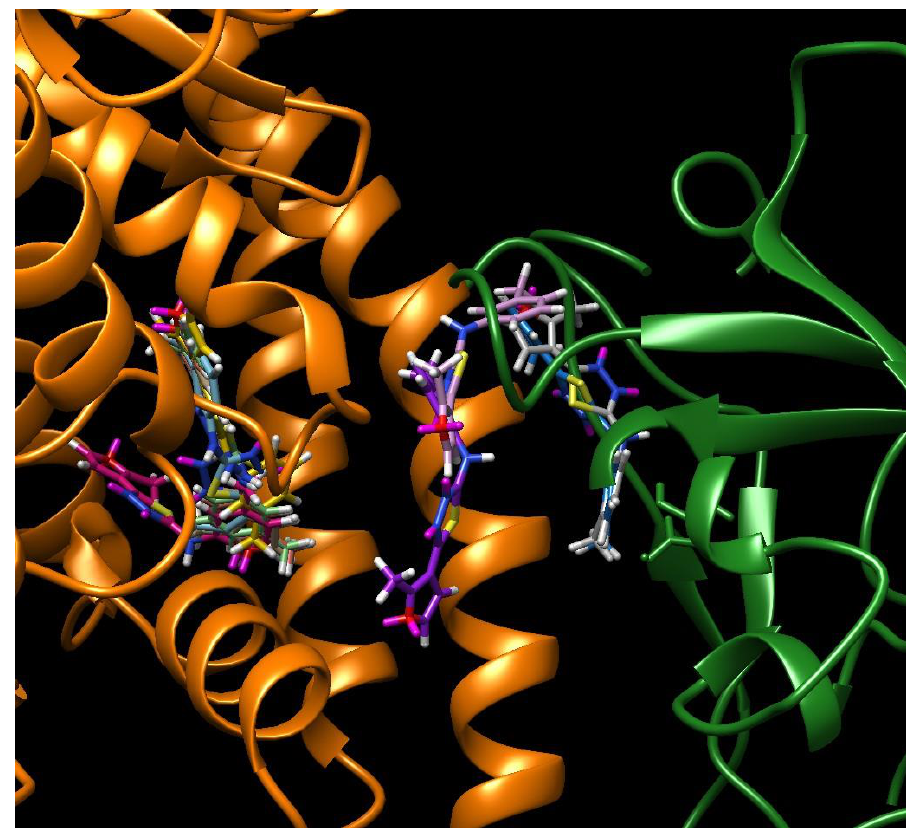
Figure 8. Overlay of the 10 best binding poses of PSmMe compound in the groove of the S-protein– Figure8. Overlayofthe10bestbindingposesof PSmMe compoundinthegrooveoftheS-protein–ACE2 ACE2 receptor interface (for color code see Figure 4). receptor interface (for color code see Figure